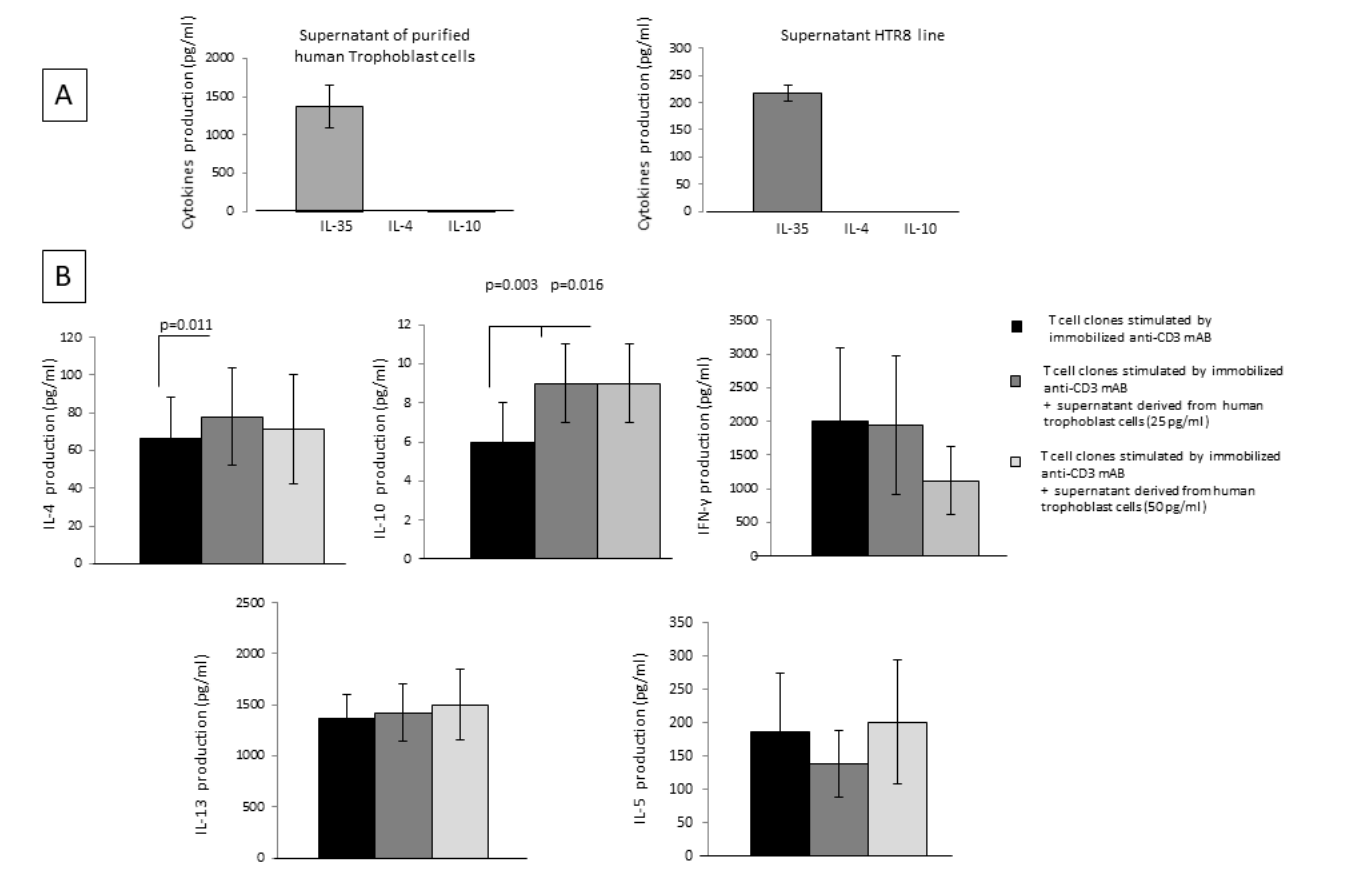
Figure 5. Trophoblast cells, through the spontaneous production of IL-35, stimulate IL-4 and IL-10 production by CD4+ T helper cells. ( A ) IL-35 was measured with a bead-based assay in the super- natant of 16 specimens of isolated human first-trimester cytotrophoblast cells and in the supernatant of 3 specimens from the trophoblast cell line HTR8. ( B ) Fourteen CD4+ T-cell clones derived from the peripheral blood of healthy subjects stimulated with immobilized anti-CD3 mAb were cultured for 36 h in the absence and in the presence of IL-35 derived from four isolated human first-trimester cytotrophoblast cell supernatants at two different final concentrations, 25 pg/mL and 50 pg/mL.